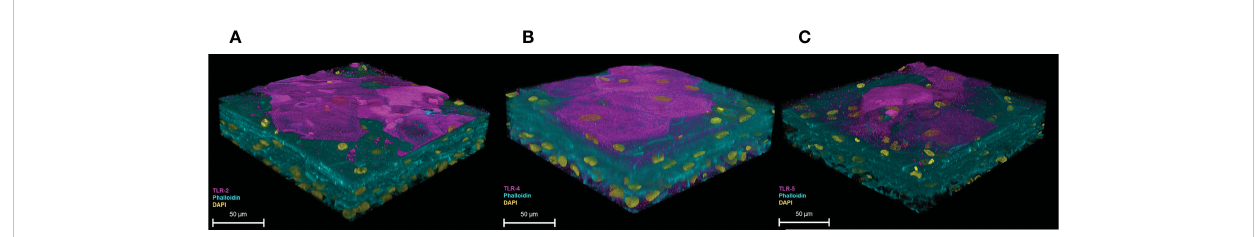
FIGURE 6 3D-UHU models express toll-like receptors. 3D-UHU expresses (A) TLR-2 (magenta); (B) TLR-4 (magenta); and (C) TLR-5 (magenta). Phalloidin- stained F-actin is presented in cyan and DAPI-stained DNA is presented in yellow; scale bars are as shown. Images are representative of at least three biologically independent experiments.